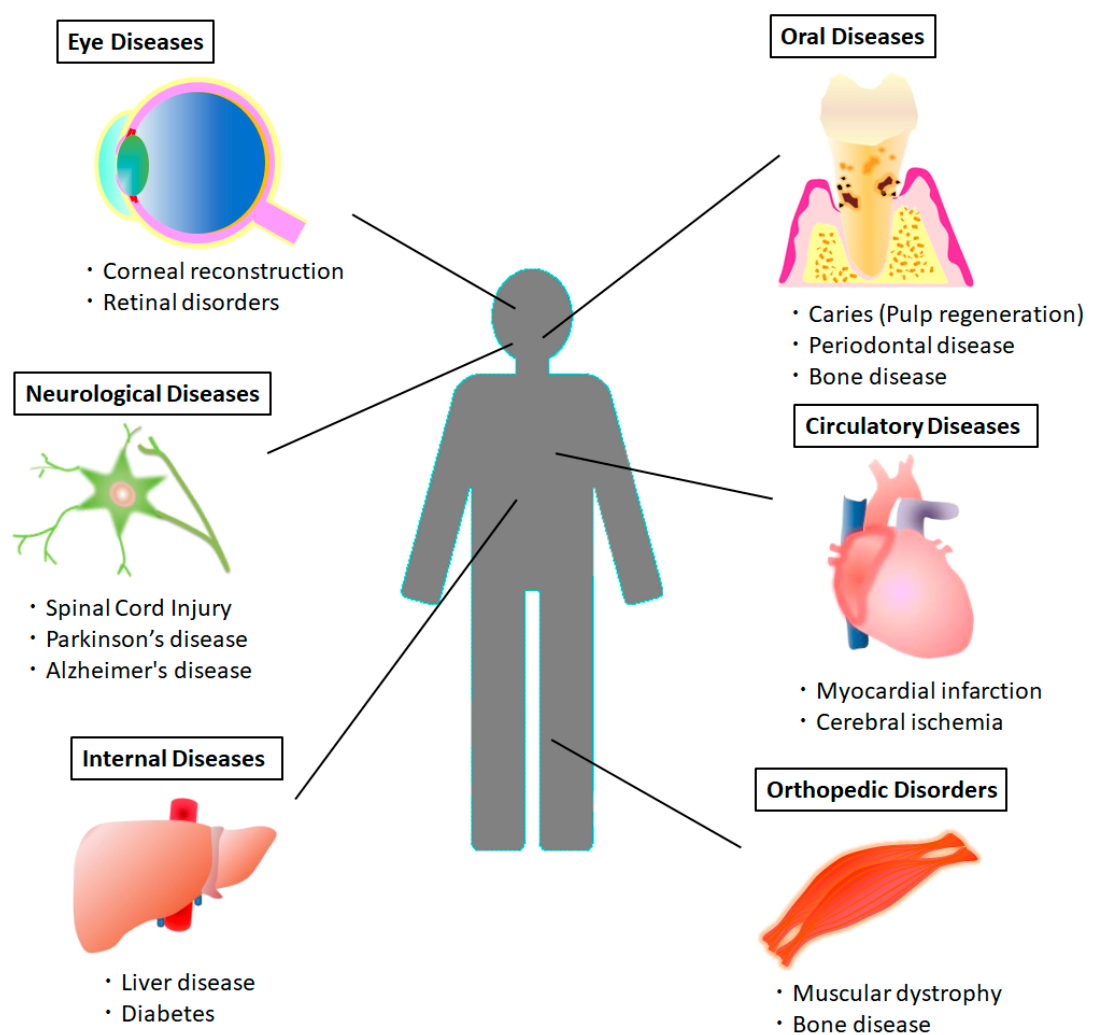
Figure 2. Application of DPSCs for treating various disorders. Transplantation of DPSCs or DPSC- derived differentiated cells is beneficial not only for oral diseases, but also for systemic diseases such as neurological disease, circulatory disease, internal disease, orthopedic disorders, and eye disease.